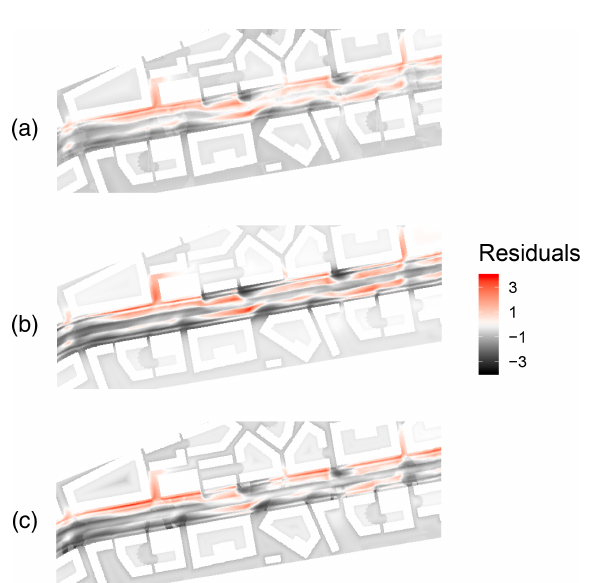
Figure 5. Model residuals of PM 2 . 5 predictions in KA20 for (a) the log-linear regression, (b) the logarithmic SVR and (c) the Gaussian process. The wind is coming from the left. Residuals are calculated after scaling with the respective optimal a for mRMSE calculation. Notice that although the residuals look similar, the predictions have notable differences. The scaled pc ranges up to a maximum of 7.28. The residuals can also be contrasted to the mean squared error of the dummy model, which is 1 . 78.